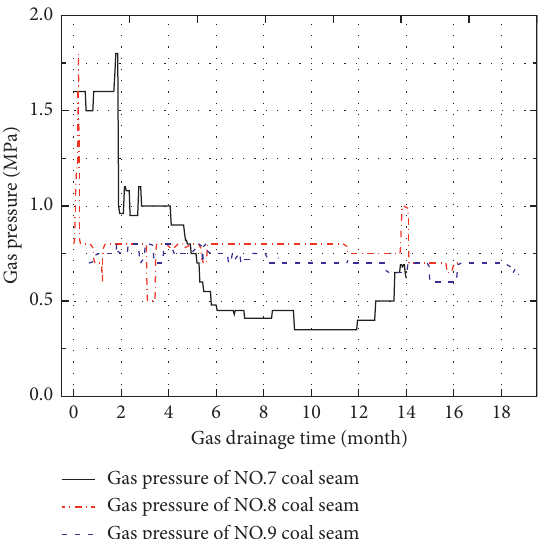
Figure 18: Variations of gas pressure in No. 7, No. 8, and No. 9 coal